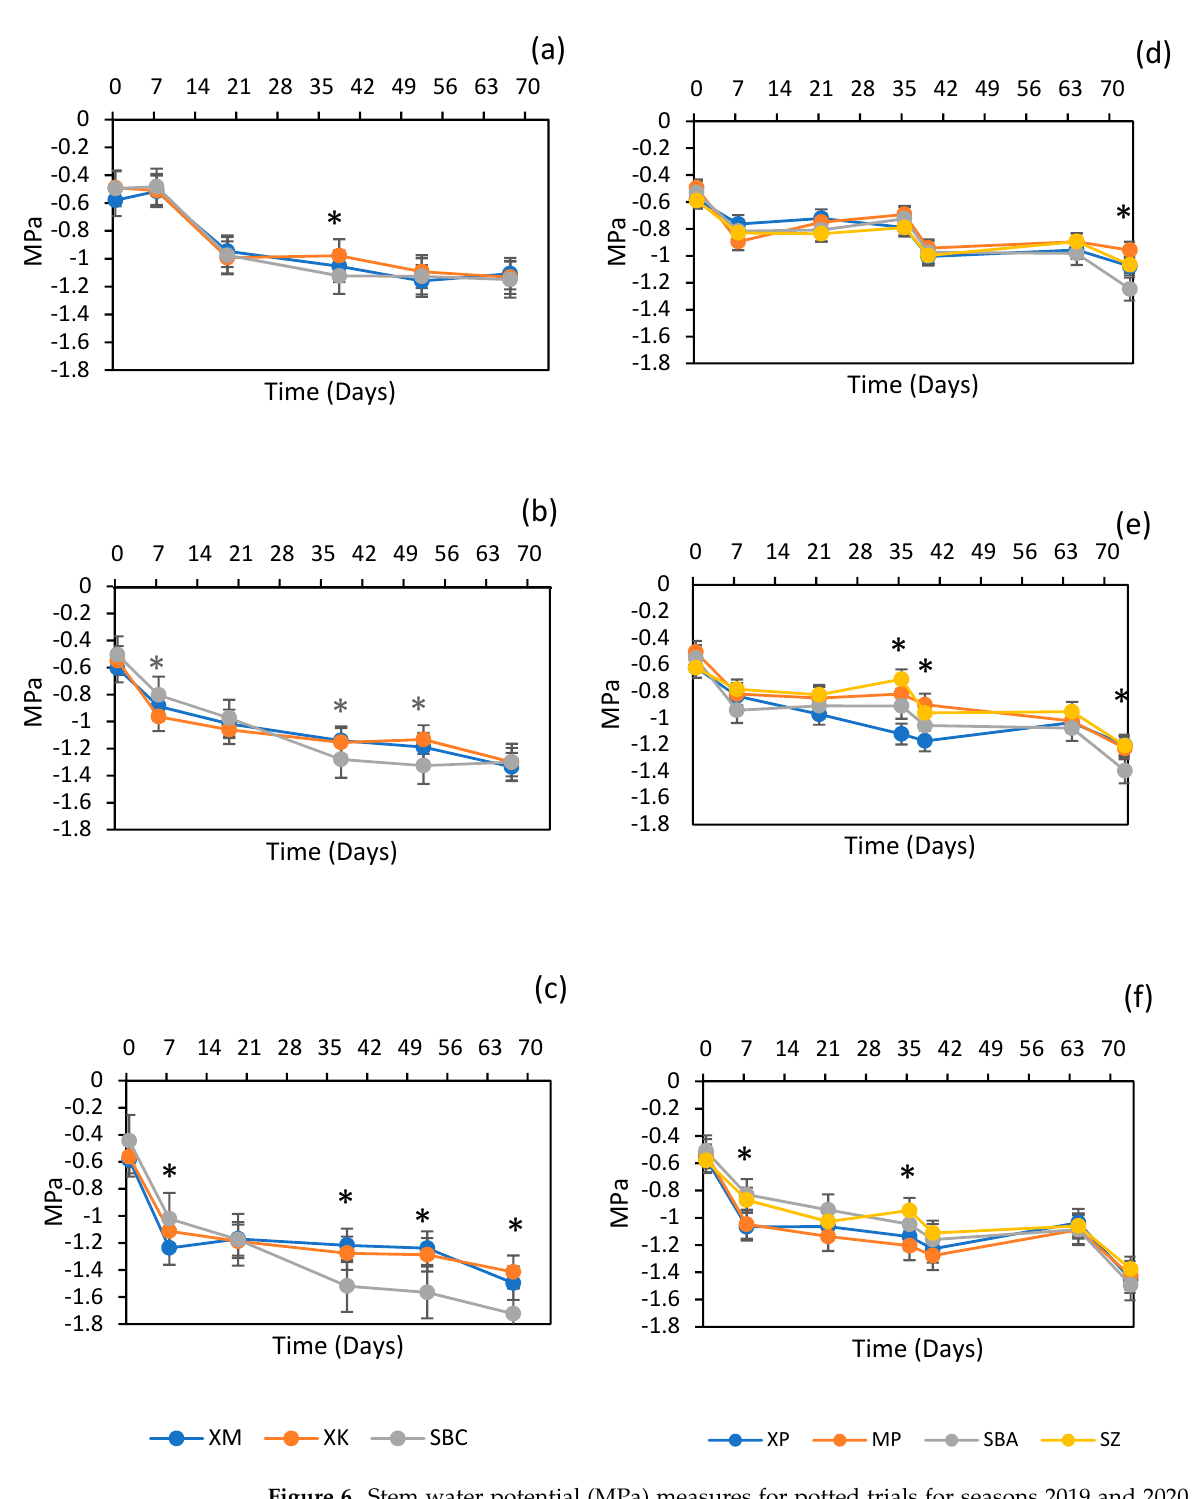
Figure 6: Stem water potential (MPa) measures for potted trials for seasons 2019 and 2020/21. XM- Xynisteri Mandria, XK- Xynisteri Kathikas, XP- Xynisteri Paphos, MP- Maratheftiko Paphos, SBC- Sauvignon Blanc Cyprus, SBA- Sauvignon Blanc Adelaide, SZ- Shiraz. (a) Full irrigation 2019, (b) 50% irrigation 2019, (c) 25% irrigation 2019, (d) Full irrigation 2020/21, (e) 50% irrigation 2020/21, (f) 25% irrigation 2020/21. Each data point are means of n=10 vines in 2019 and n=7 vines in 2020/21. Bars indicate the standard error. Means were separated by ANOVA using Tukey’s test. * indicate significance at p < 0.05.